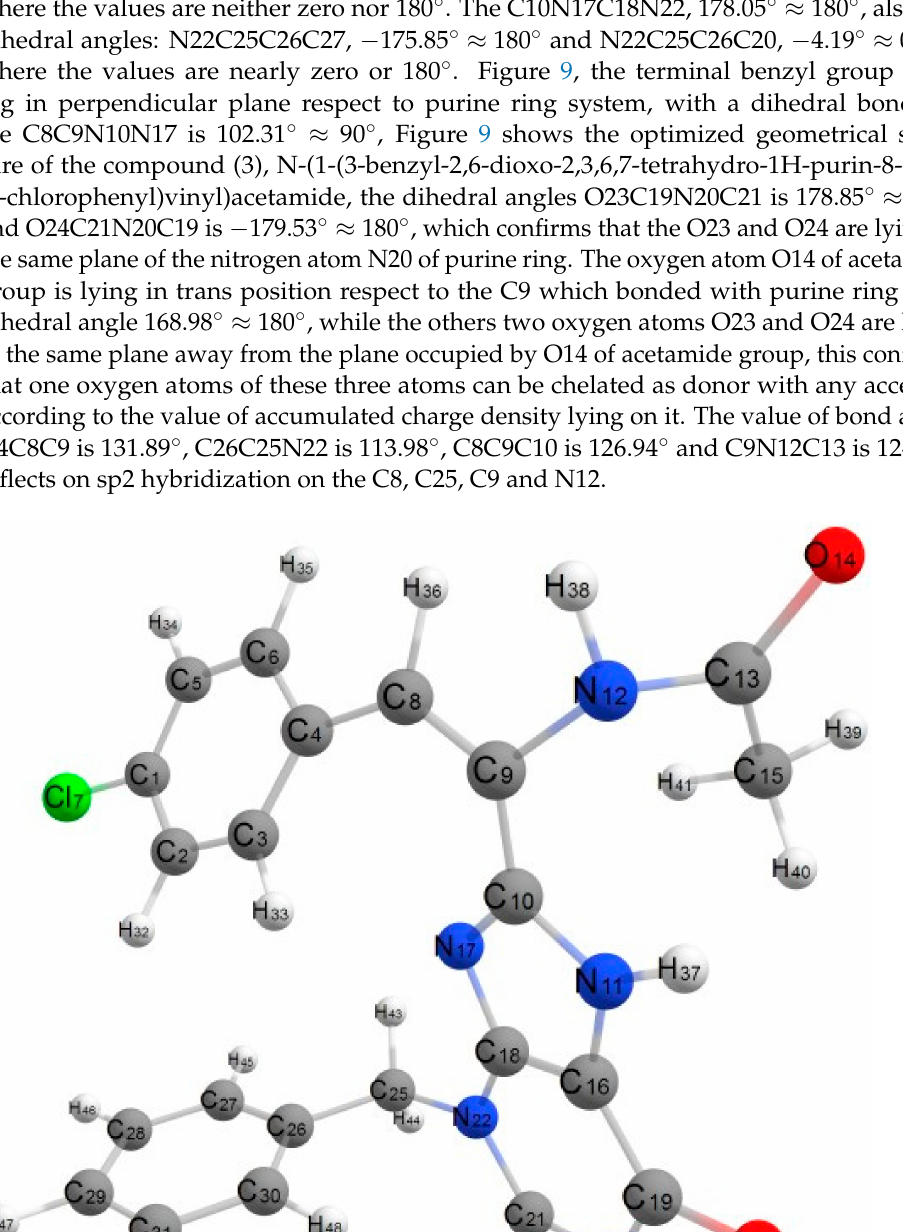
atoms, the highest charged atoms are O14 of carbonyl group in acetamide with −